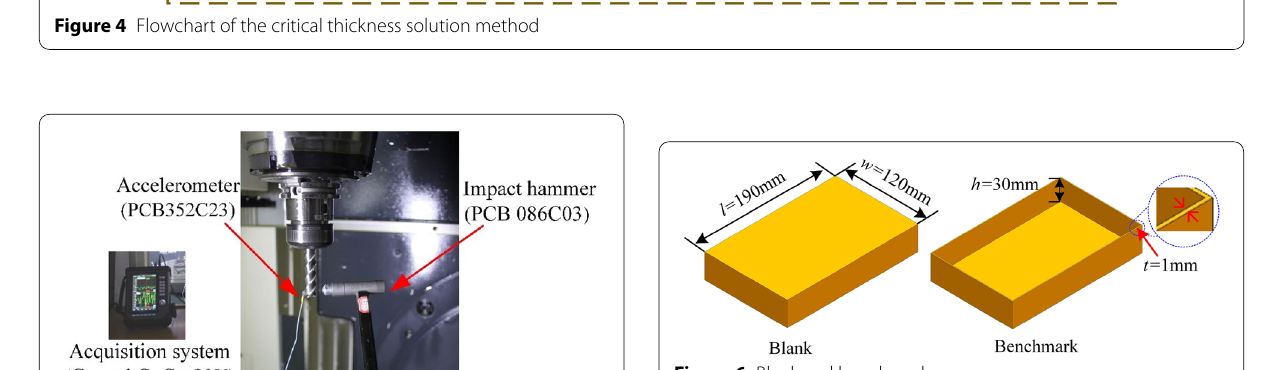
Figure 6 Blank and